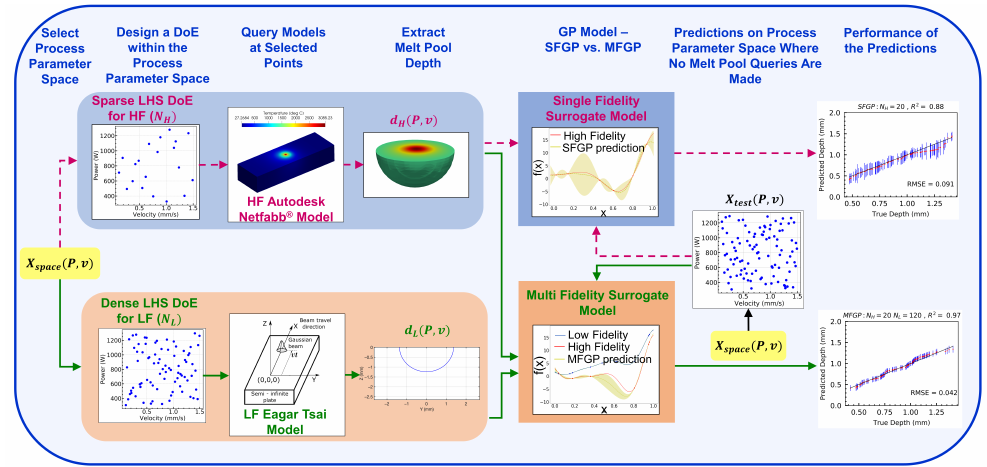
Figure 9. Framework followed for developing the forward process maps at discrete time instants using SFGP/MFGP. The solid green line indicates the path of the MFGP regression while the dashed magenta line indicates the path of the SFGP